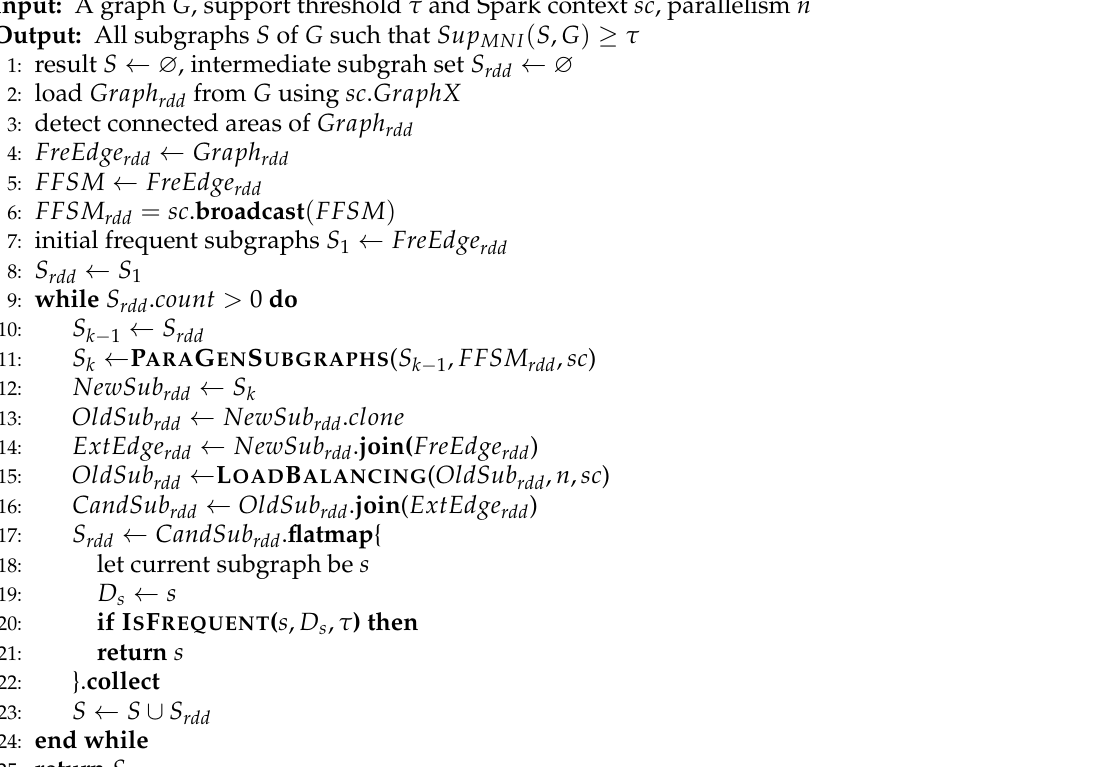
Algorithm 4 The SS I G RA M